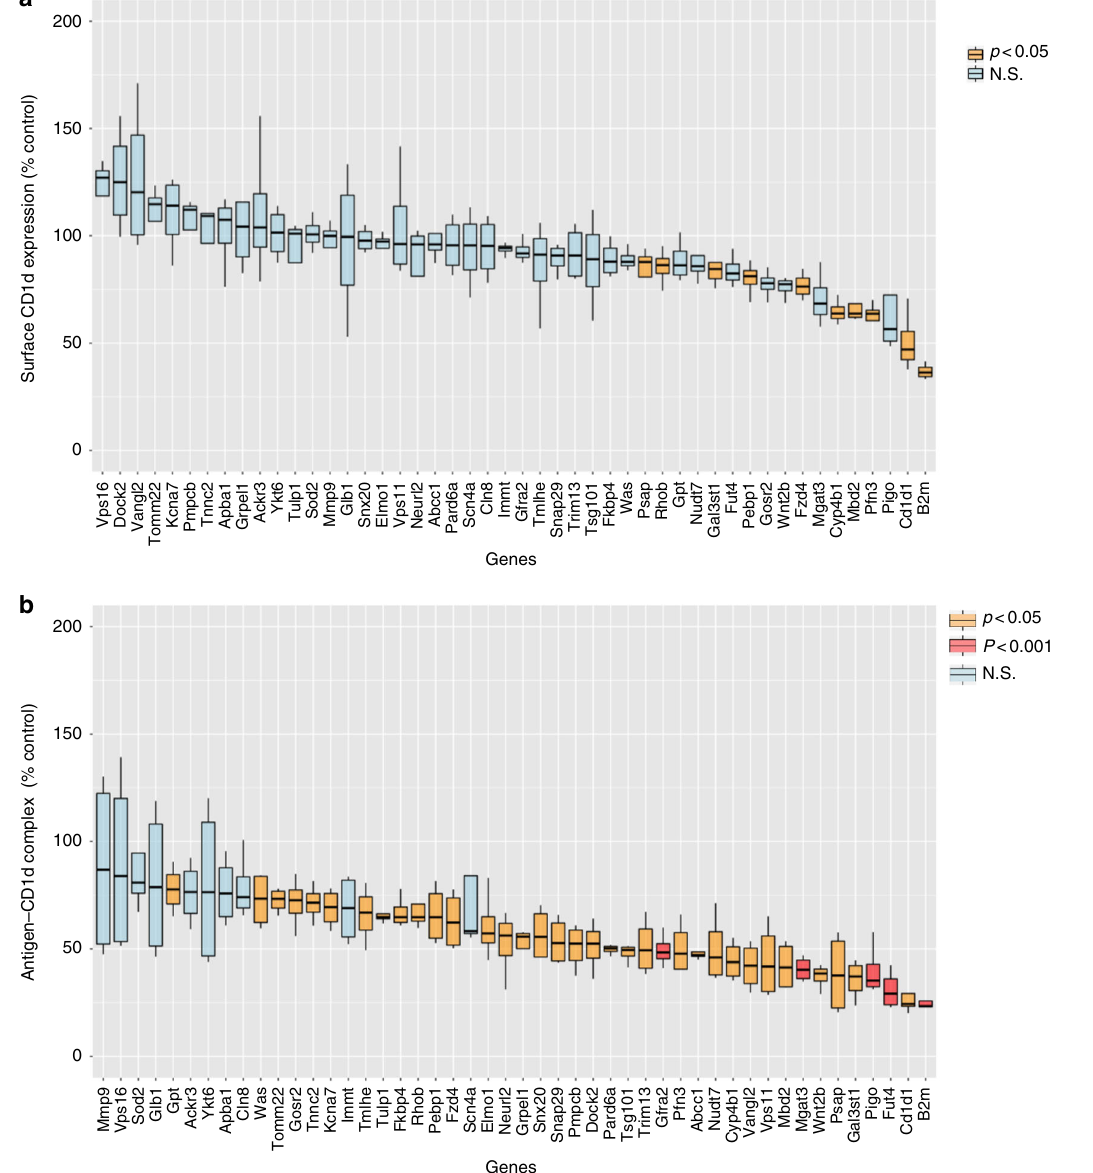
Fig. 4 Gene knockdown effects on surface CD1d and CD1d-lipid complex formation. a Effect on CD1d surface expression assessed by fl ow cytometry. The fi gure represents percentage change in mean fl uorescence intensity (MFI) as compared to a non-targeting control. Average value from four experiments is shown. b Flow cytometry analysis of surface expression of α GalCer-CD1d complexes by J774-CD1d cells (live, singlets) after GalGalCer loading. Normalized MFI compared to non-targeting control, the average of four experiments is shown. Boxes represent the interquartile range; maximum and minimum values are displayed with vertical lines. p -Values are indicated (paired t -test). See also Supplementary Fig. 3, 4, 5 and